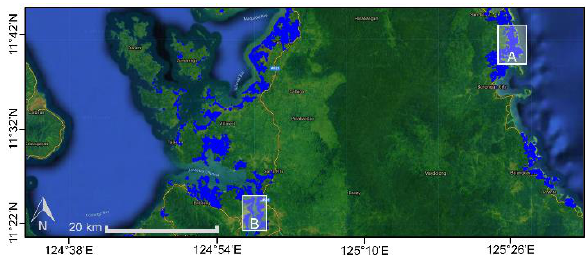
Figure 17 . Sites with varying thresholds in tile 51PYN: in (A) Canhauay, Eastern Samar, and along (B) San Juanico Strait. The blue pixels are classified as mangroves in the MVI-based 2019 Mangrove Extent Map of the Philippines. The computed areas of mangrove cover in these sites using the original and optimal site-specific thresholds are summarized in Table 2.